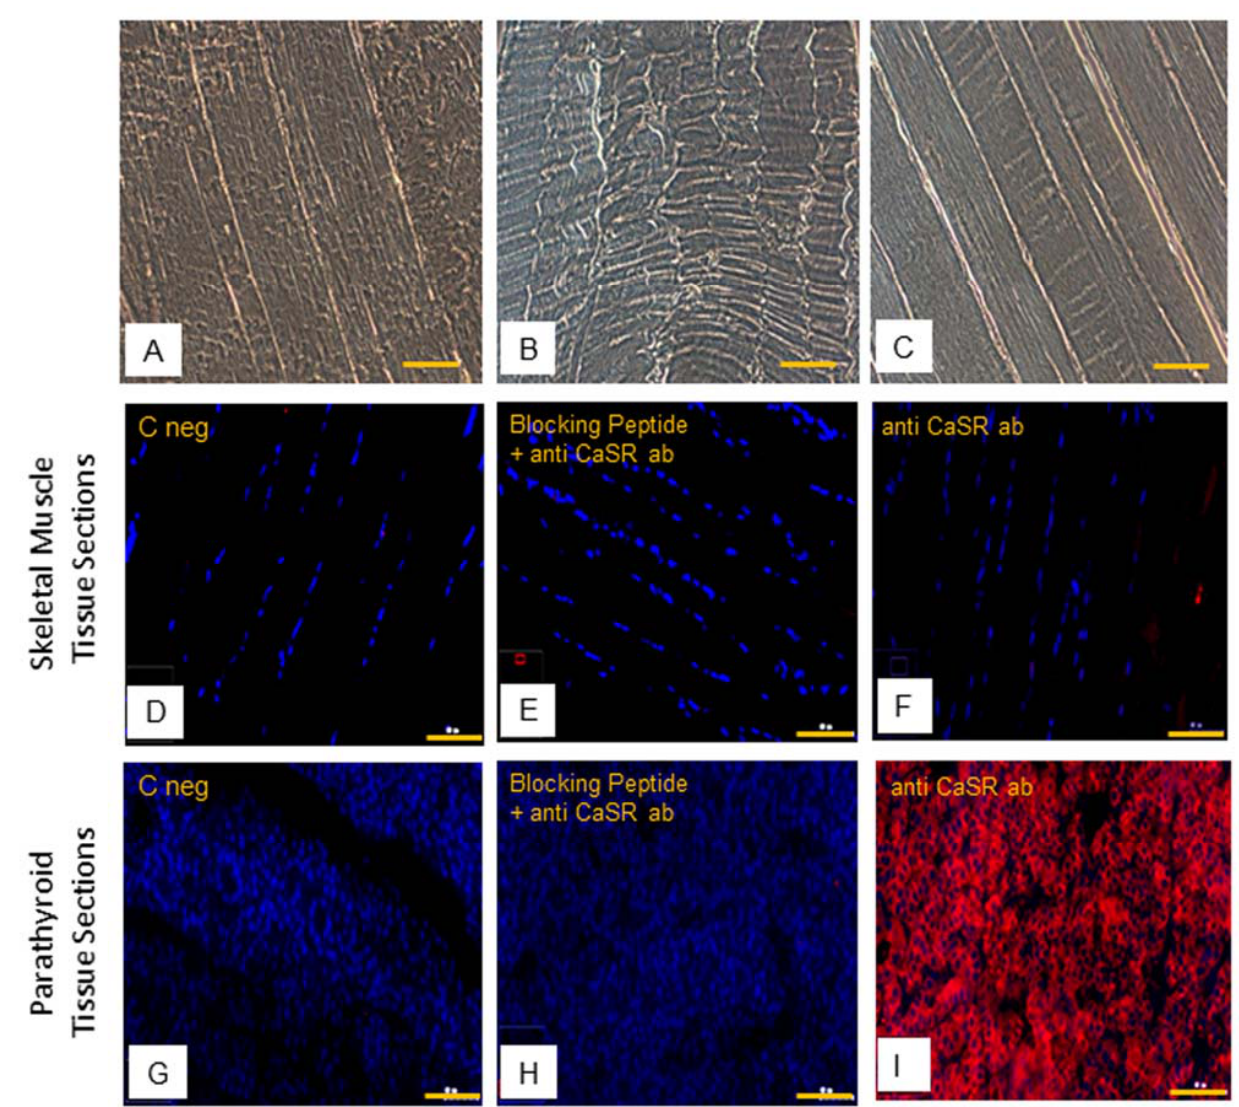
Figure 6. Human skeletal muscle tissue (hSMt) sections; observations in phase contrast microscopy, original. Magnification: 10×, scale bar 200 µm ( A – C ). Immunostaining of CaSR protein. Analysis of CaSR protein in human skeletal muscle tissue sections: ( D ) negative control only with secondary antibody, ( E ) control with anti-CaSR antibody absorbed with blocking peptide, and ( F ) with primary anti-CaSR antibody. Analysis of CaSR protein in human parathyroid tissue sections used as positive control: ( G ) negative control with only secondary antibody, ( H ) control with anti-CaSR antibody absorbed with blocking peptide, and ( I ) with primary anti-CaSR antibody. Fluorescent microscopy in conventional colors: red for CaSR and blue for nuclei, original magnification: 10×, scale bar: 200 µm. Experiment was carried out in triplicate (in hSMt sections of three different humans).